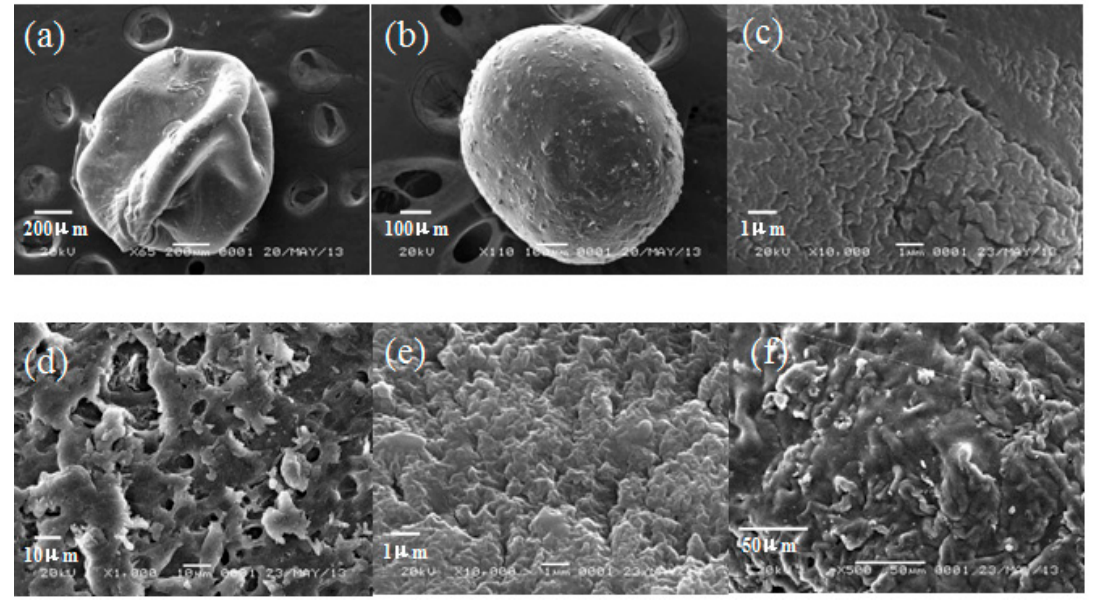
Figure 2. SEM of chitosan bead, clay/chitosan composite beads and immobilized lipases, spherical shapes of CB ( a ) and CCB-5 ( b ) surfaces of CB ( c ); CCB-5 ( d ); CB-lipase ( e ) and CCB-5-lipase ( f ).